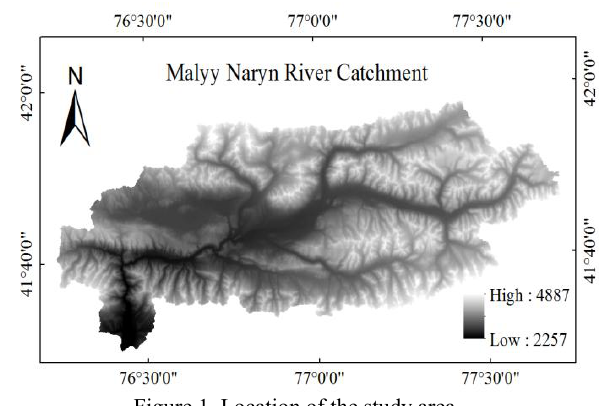
Figure 1. Location of the study